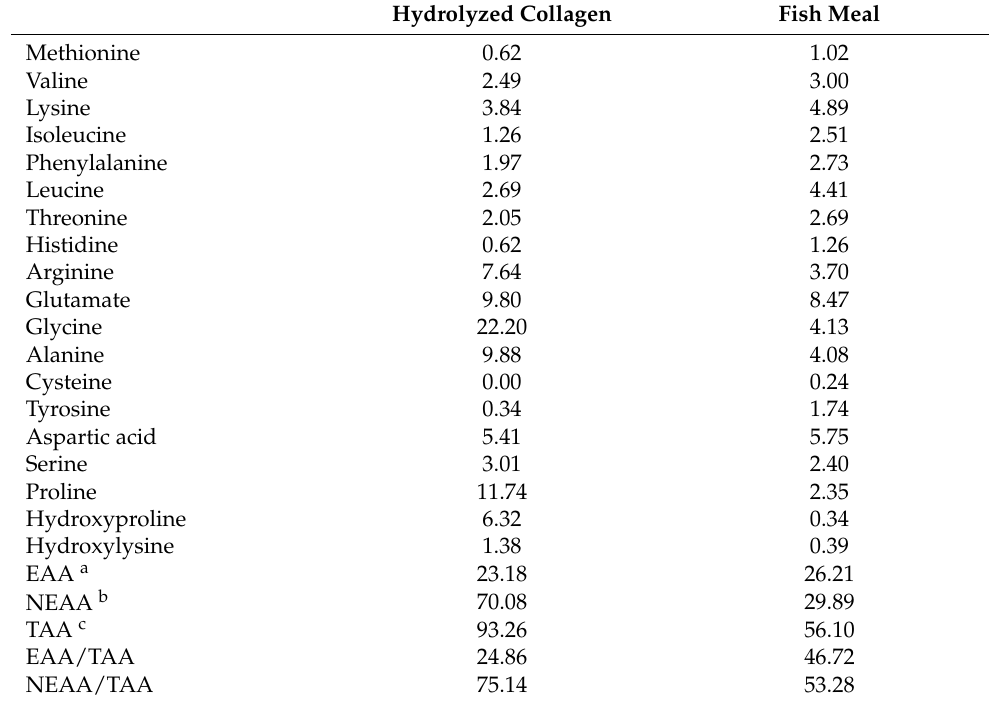
Table 3. Comparison of amino acids between hydrolyzed collagen and fish meal (% dry matter). Hydrolyzed Collagen Fish